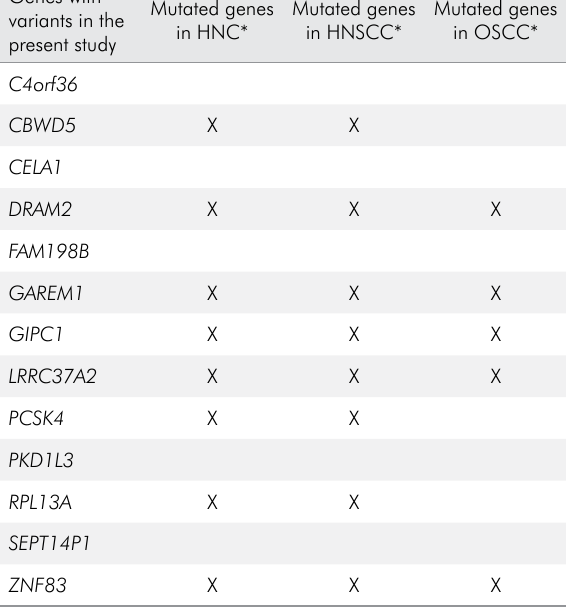
OED: oral epithelial dysplasia; HNC: head and neck cancer; HNSCC: head and neck squamous cell carcinoma; OSCC: